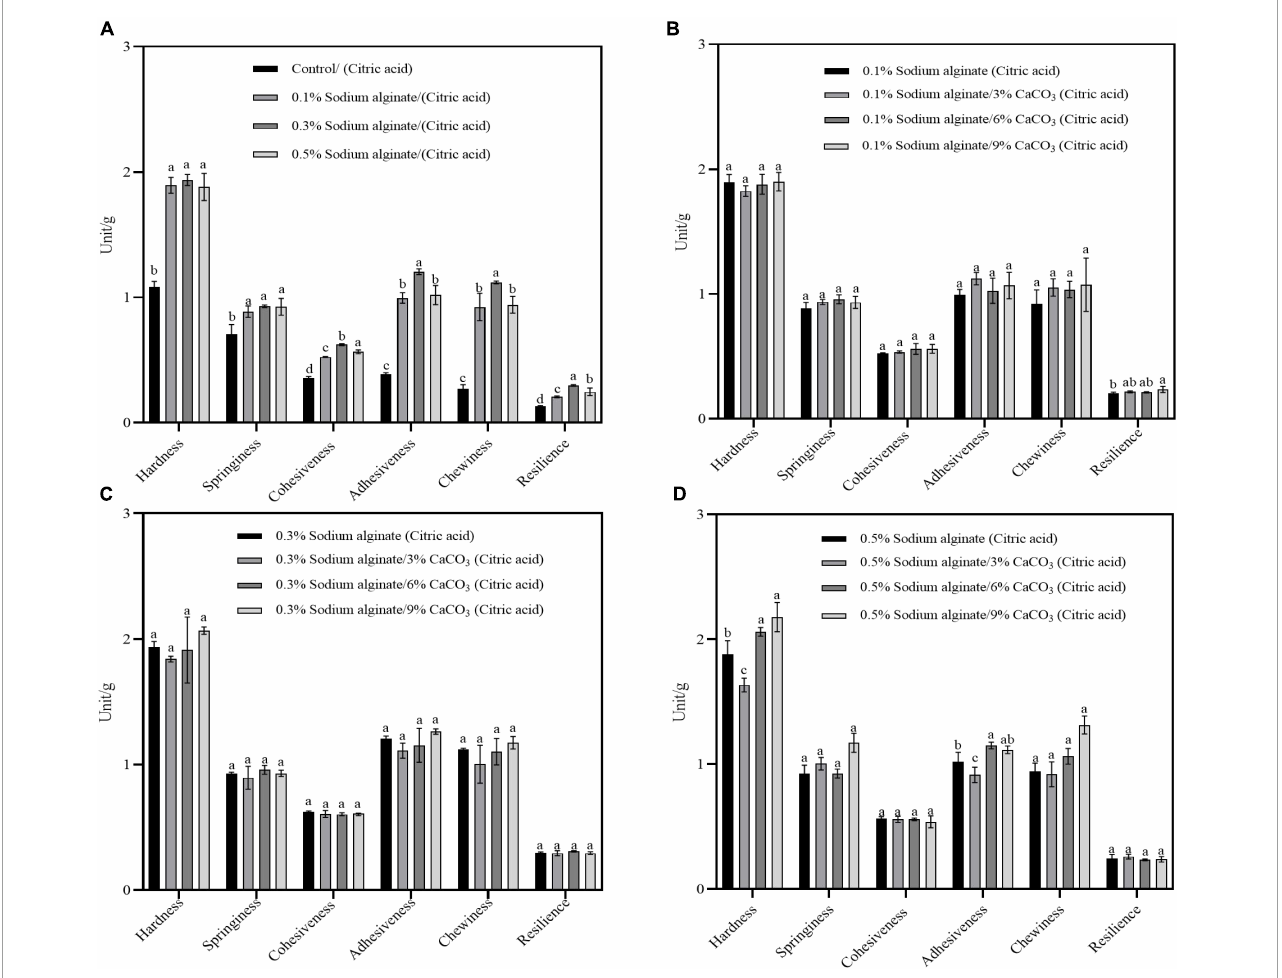
FIGURE2 (A–D) Show the effects of Ca 2 + concentrations of the textural properties of noodles prepared by the endogenous method. The solution environment for cooking noodles in panels (A–D) is 0.1 g/L citric acid solution (pH = 4).